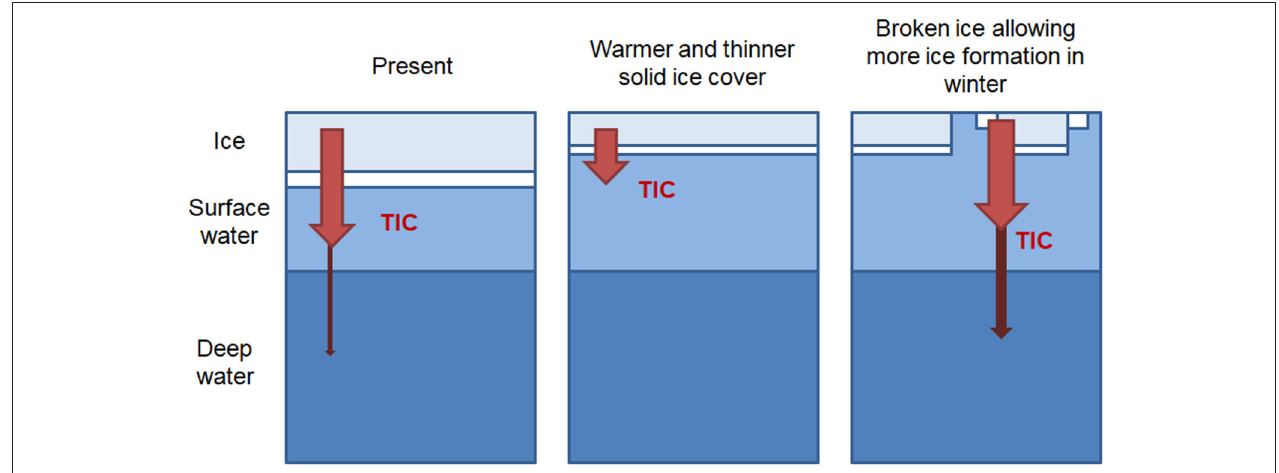
FIGURE 8 | Schematic illustration of the implications of our findings for future scenarios conditions. A thinner and warmer, but complete ice cover and a decrease in total sea ice production leads to a decrease in TIC export to deep water layers. Increased openings within the sea ice cover during winter increase total sea-ice production and export of TIC to deeper water